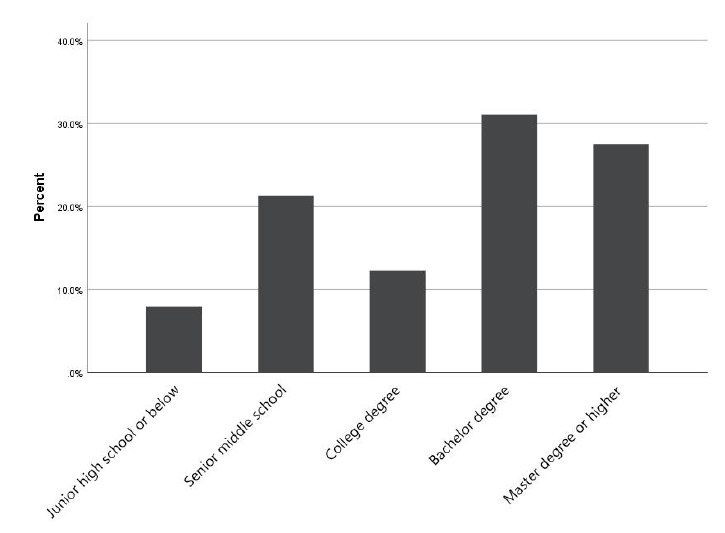
Figure 3. Education level distribution of the respondents.